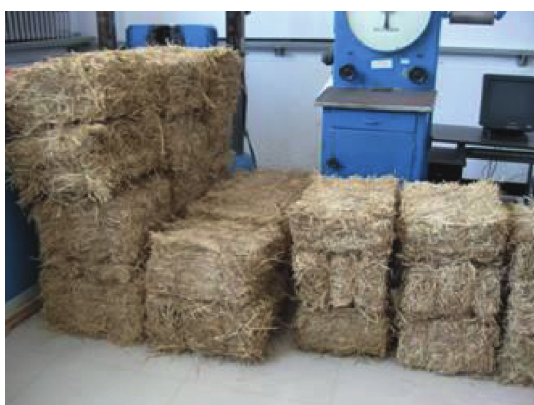
Figure 2: The rice straw specimens.